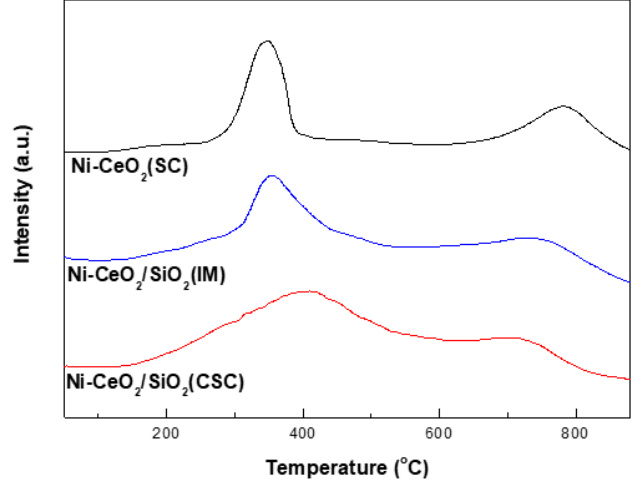
Figure 4. H 2 temperature - programmed reduction (H 2 -TPR) profiles of the Ni-CeO 2 (SC), Ni- CeO 2 /SiO 2 (IM) and Ni-CeO 2 /SiO 2 (CSC) catalysts .